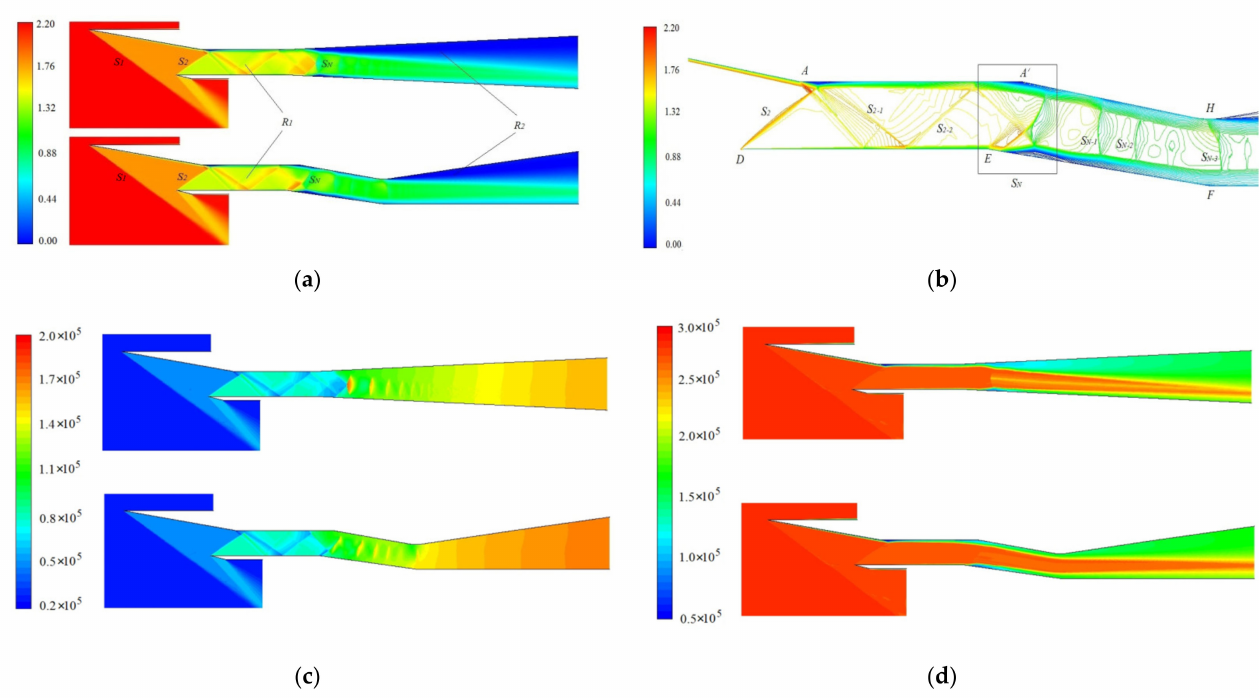
Figure 7. Comparison of the contours of Ma ∞ 2.2. ( a ) Mach number; ( b ) Shock wave system; ( c ) Static pressure; ( d ) Total